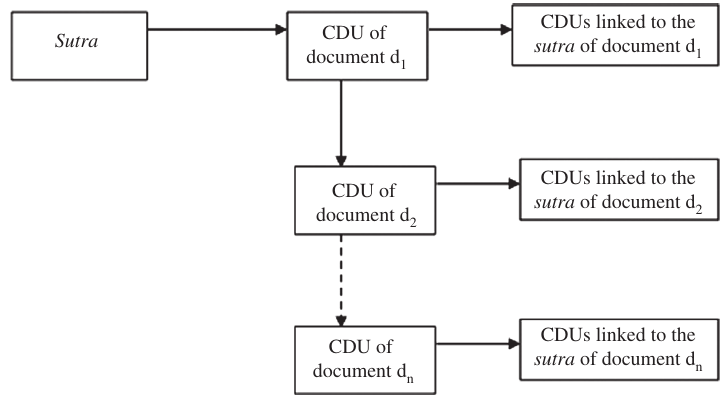
Figure 9. Representation of the Sutra as an Inverted